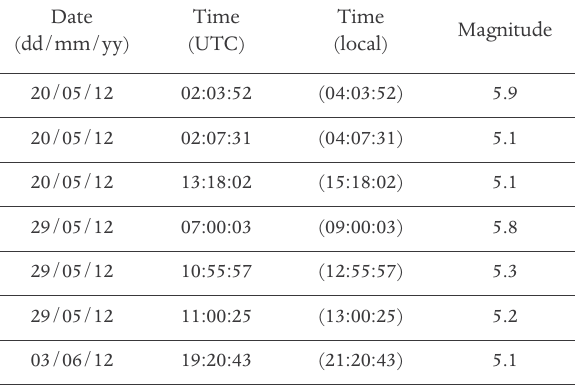
Table 1. The May-June 2012 seismic sequence in